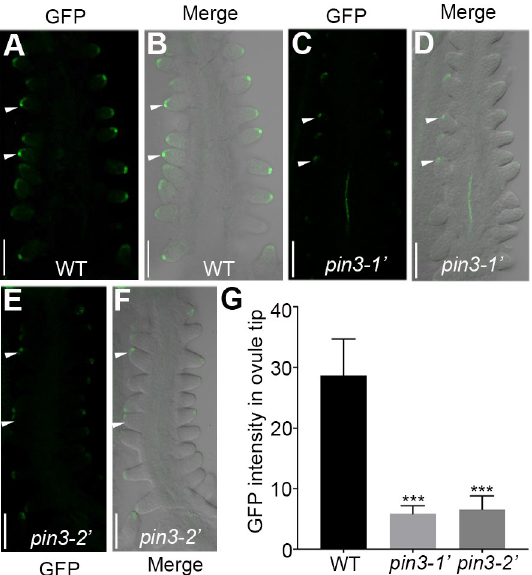
Fig 4. DR5 signal is compromised in pin3 ovules at floral stage 10. (A-F) Confocal microscopy observations of the DR5 :: NLS-eGFP reporter in the wild-type (A-B), pin3-1’ (C-D), and pin3-2’ (E-F) backgrounds. (G) Quantification of DR5 fluorescence intensity in the ovule tip. Ten independent pistils were analysed. Bars: 50 μ m. White arrows